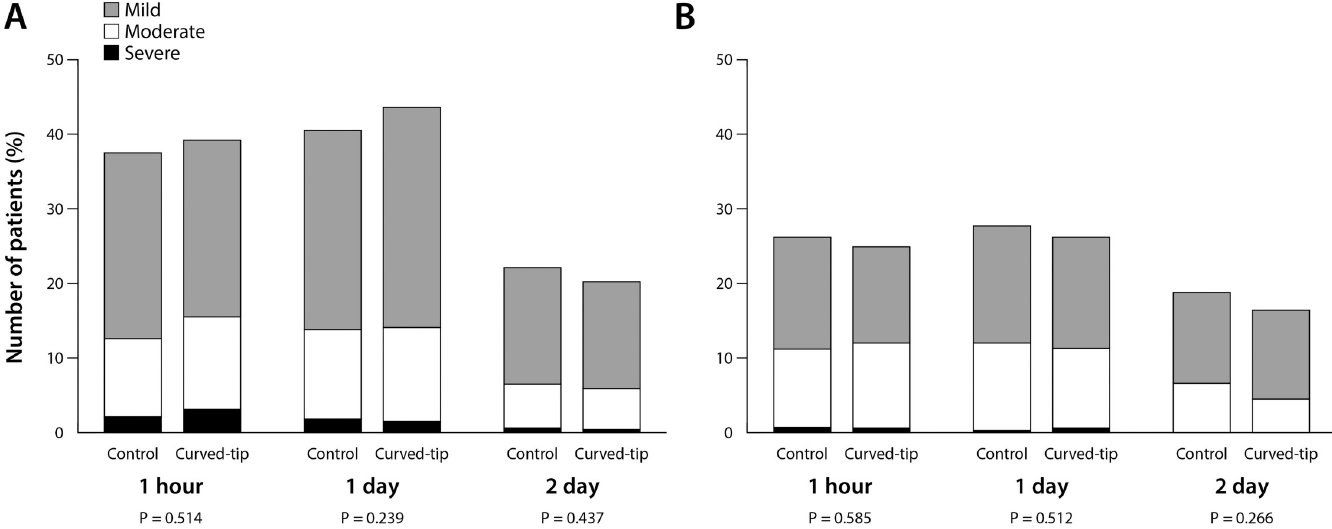
Fig 5. The incidence and severity of sore throat (A) and hoarseness (B) one hour, one and two days after extubation of left-sided double-lumen tubes. P values were obtained by comparing the incidence of sore throat (A) and hoarseness (B) between groups using Fisher’s exact tests.